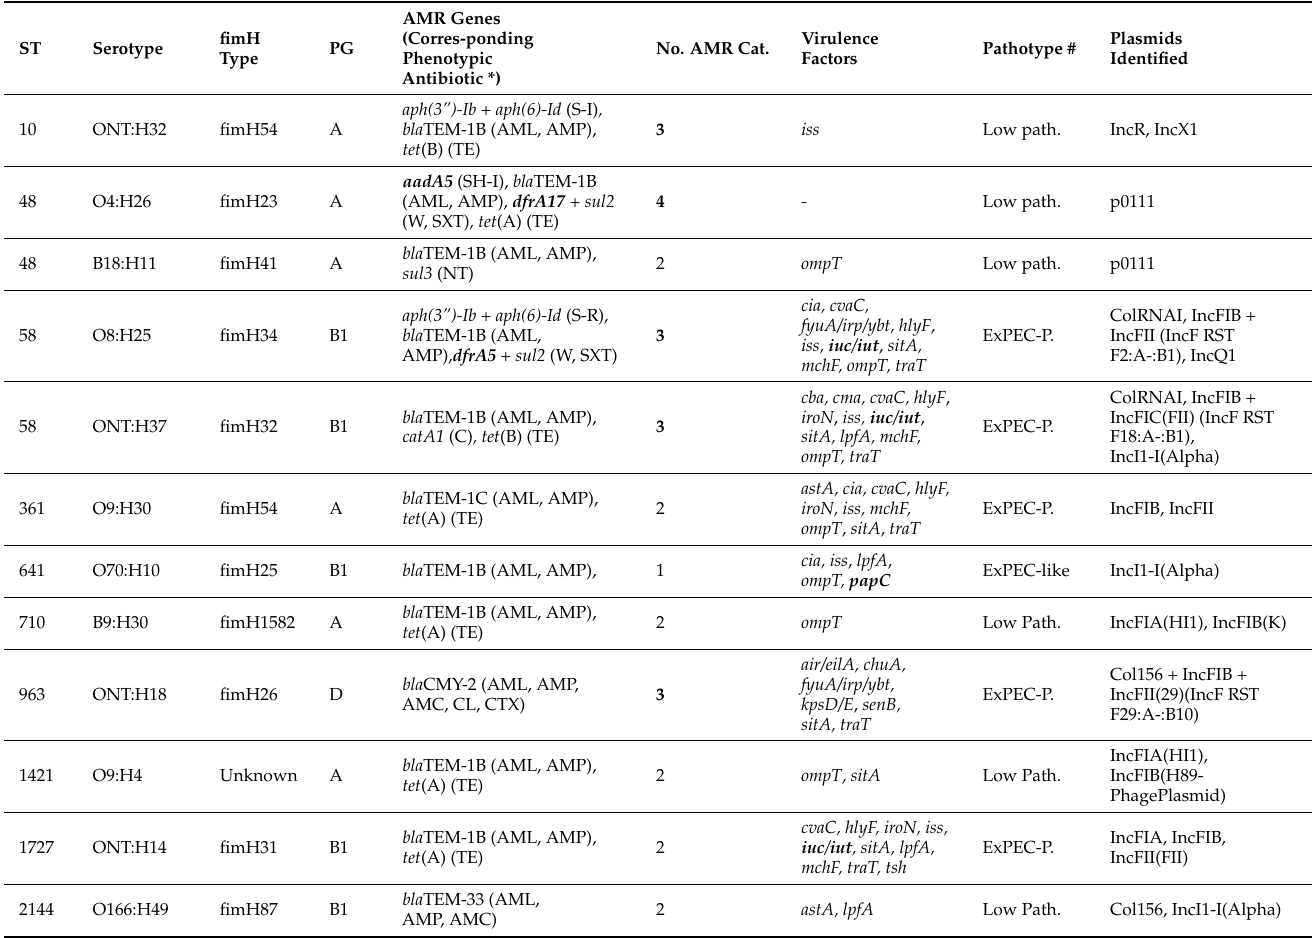
Table 1. Genetic characterisation of amoxicillin-resistant strains from orphaned, abandoned, and heat- stress-affected grey-headed flying fox pups entering care in South Australia during the 2018/2019 pup season. Antimicrobial resistance (AMR) genes associated with class 1 integrons are highlighted in bold. Key ExPEC virulence factors are highlighted in bold. Multidrug resistance is defined as resistance to ≥ 3 antimicrobial categories (Cat.) and are highlighted in